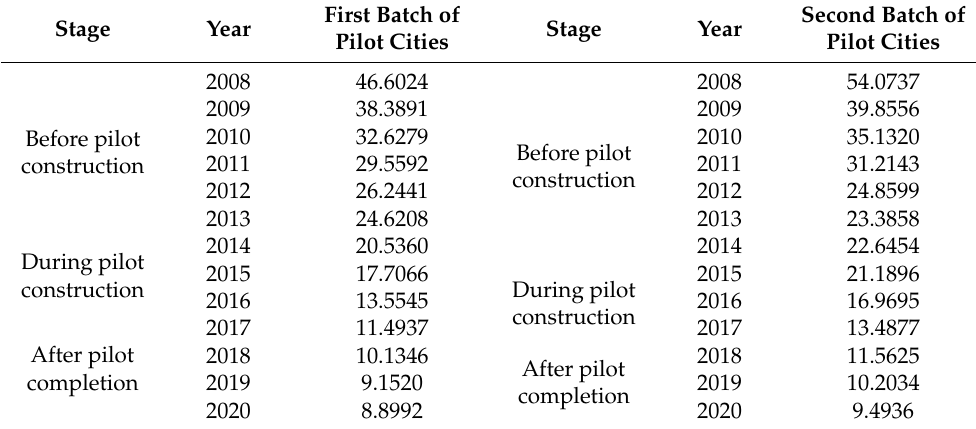
Second Batch of Pilot Cities